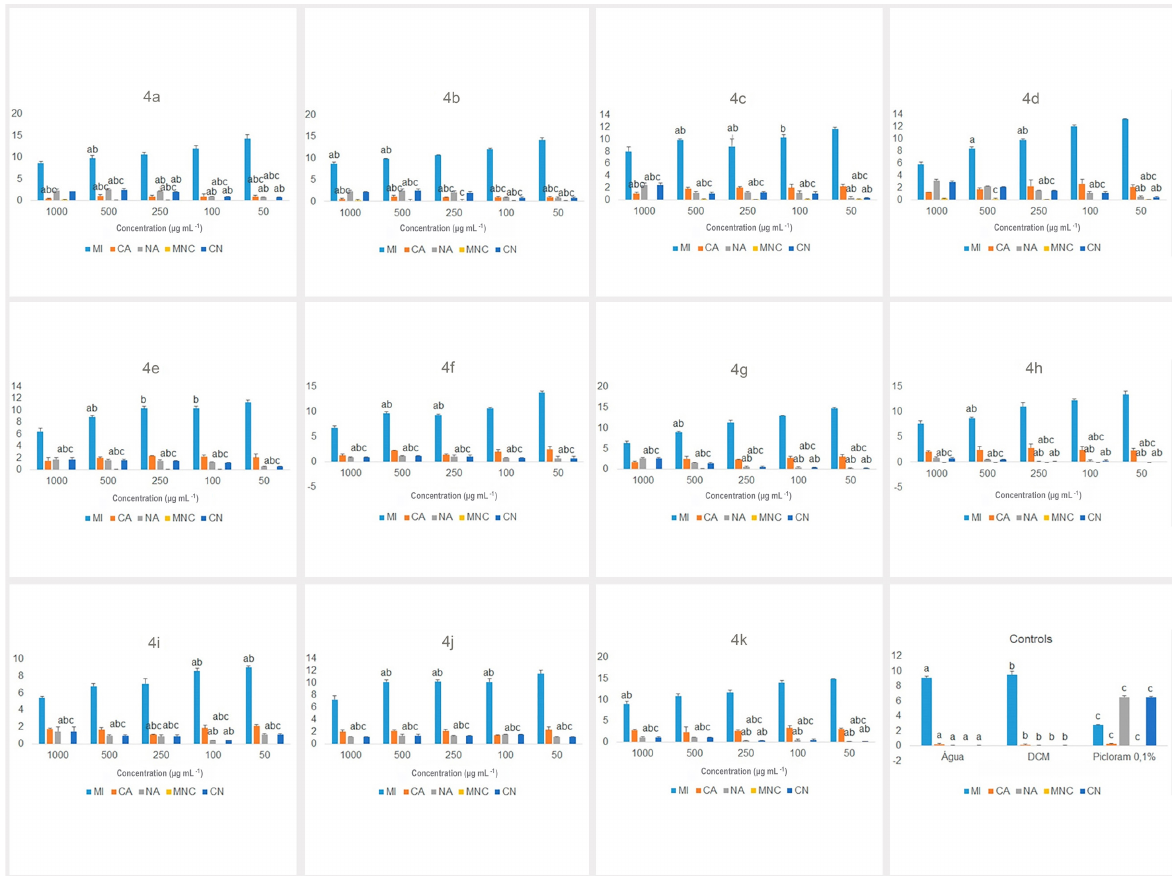
Figure 3. Cytogenotoxic variables evaluated in Lactuca sativa meristematic cells treated with five concentrations of triazoles 4a to 4k and positive control (picloram) and negative controls (water and dichloromethane) ( l ). Where: MI = Mitotic index; CA = Chromosome alterations; NA = Nuclear alterations; MNC = Micronucleus; CN = Condensed nucleus. The means followed by the letter a were equal to the negative control water, those followed by the letter b were equal to the negative control dichloromethane and those followed by the letter c were equal to the positive control picloram (0.1%) according to the Dunnett test ( p